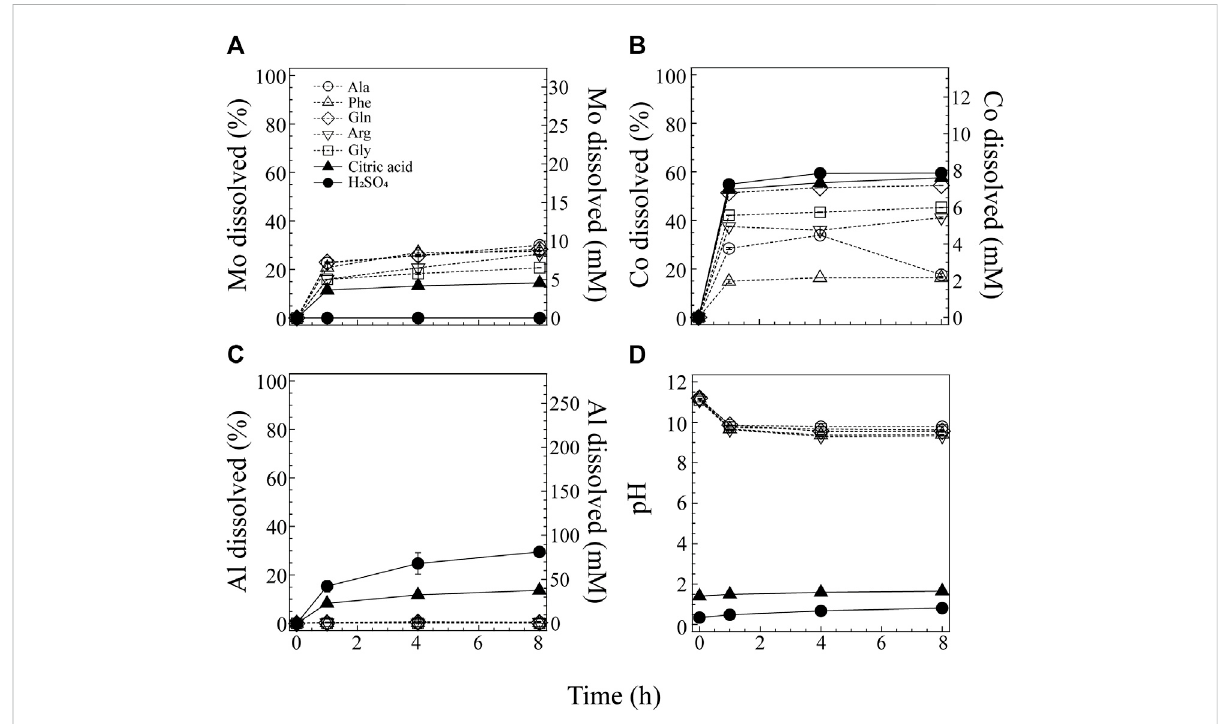
Based on the pourbaix diagram for Mo (Supplementary Figure S1; Lyon, 2010), Co (Supplementary Figure S2;